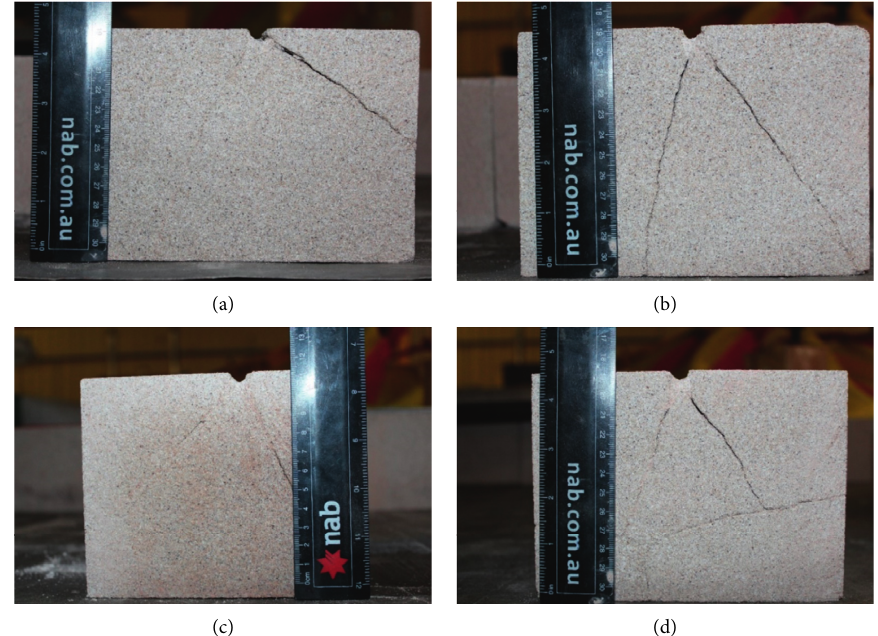
Figure 14: Crack development on the cross section under V shape disc cutter with 6 mm penetration.Confining stress: (a) 0MPa; (b) 3MPa; (c) 6MPa; (d) 9MPa.